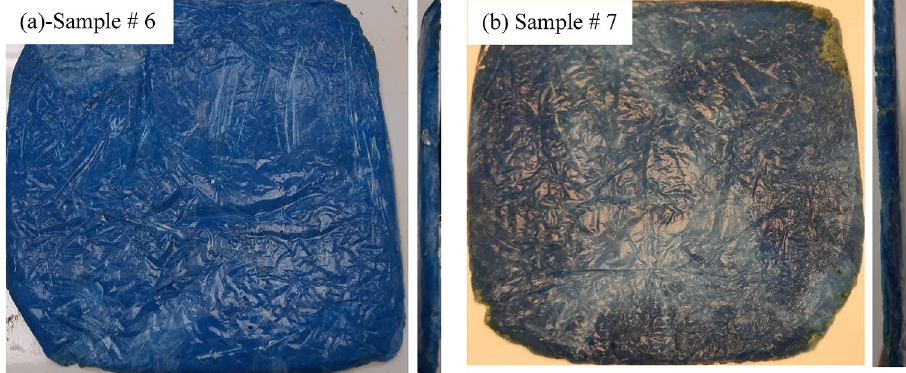
Figure 5. Melted masks ( a ) with metal nose clips and ( b ) without metal nose clips.